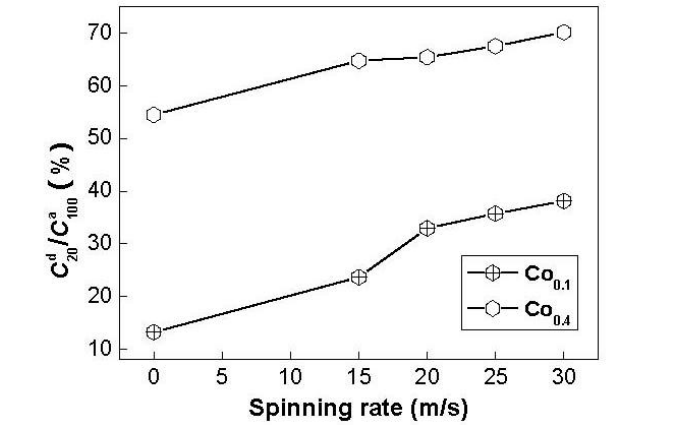
Figure 8. Evolution of the hydrogen desorption ratio ( d R spinning